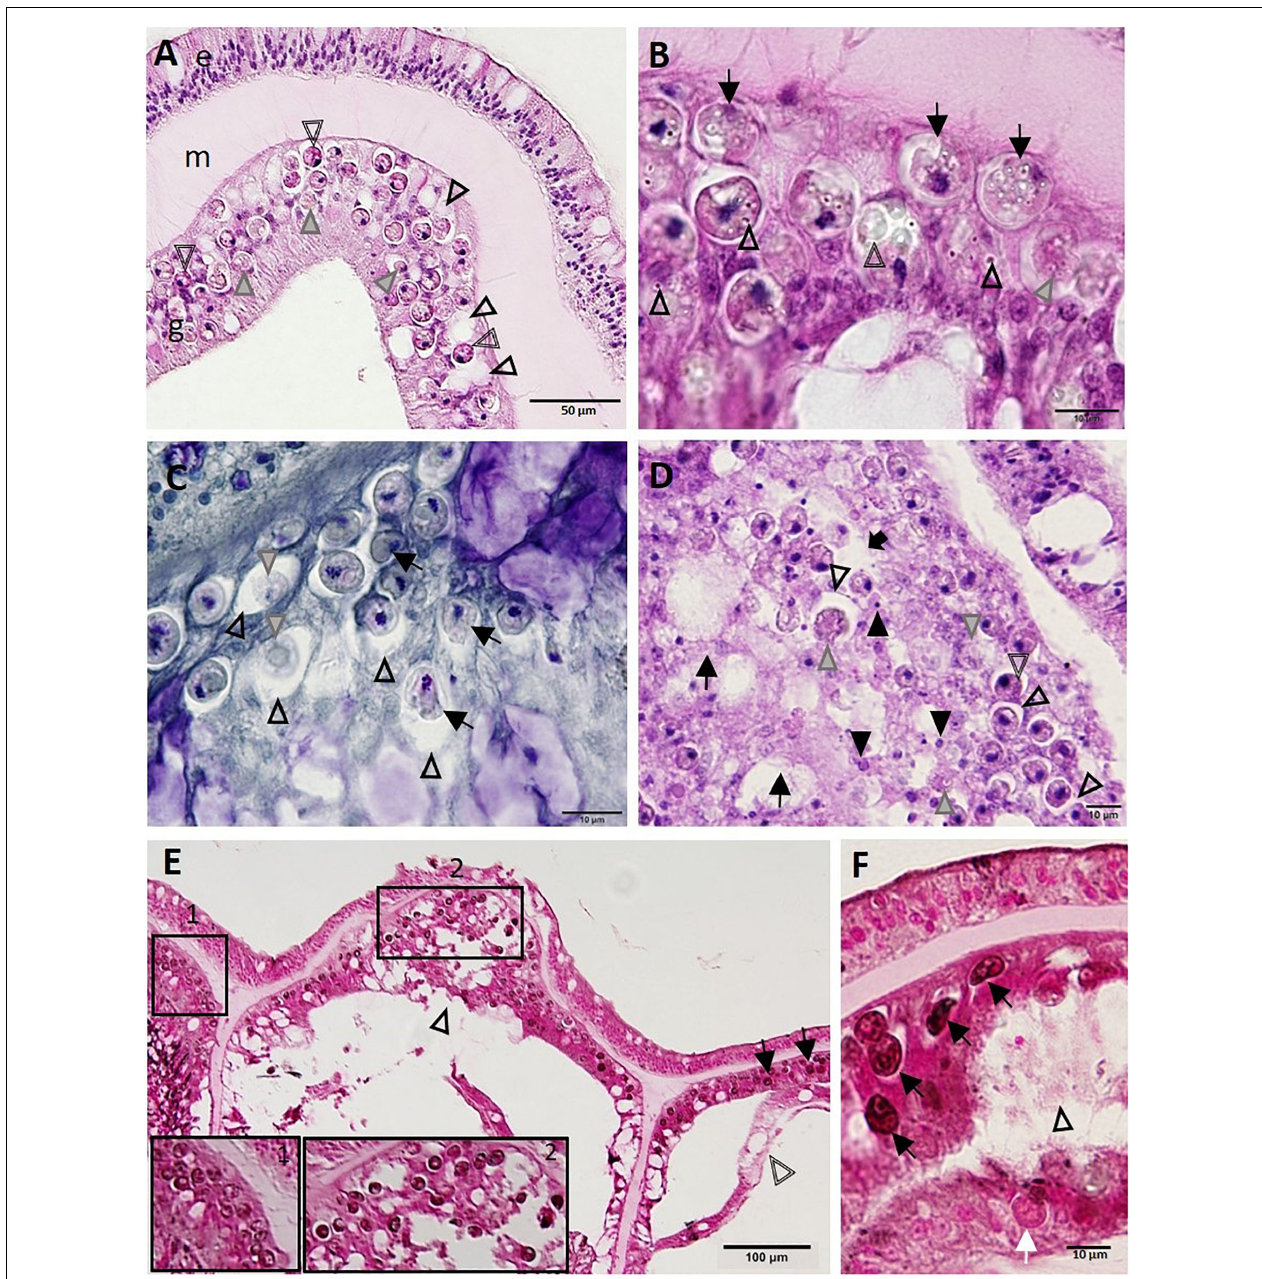
FIGURE 7 | Progressive zooxanthellae pathology in the surface body wall. (A) Intact mesoglea and epidermis with initial zooxanthellae pathology in the gastrodermis in Montastraea cavernosa . Note necrotic zooxanthellae with dilated symbiosomes (gray arrowheads) and cytoplasmic hypereosinophilia (double-line arrowheads), and coalescing vacuolation of the gastrodermis (arrowheads). (B) Gastrodermis of M. cavernosa showing deformed zooxanthellae (arrows) with intracytoplasmic refractile vacuoles (arrowheads), hypopigmentation (gray arrowhead), or fragmentation (double-line arrowhead). (C) Gastrodermis of Diploria labyrinthiformis manifesting zooxanthellae disruption. Note distended symbiosomes (arrowheads) with some zooxanthellae showing deformation (arrows) or coagulation necrosis (gray arrowheads). (D) Gastrodermis of Colpophyllia natans manifesting multifocal necrosis. Note massive disruption and lytic necrosis (LN) of gastrodermal cells (black arrows) with karyorrhectic and pyknotic nuclei (closed arrowheads), deformed and necrotic zooxanthellae (gray arrowheads), some of which manifest cytoplasmic hypereosinophilia (double-line arrowhead) or dilation of symbiosomes (open arrowheads) that eventually coalesce (black arrow). (E) Apparently healthy zooxanthellae (pink-red to light brown) with evident pyrenoids and lack of visible symbiosomes (inset 1) in intact SBW gastrodermis of M. cavernosa . Compare to abnormal dark zooxanthellae with no pyrenoids and dilated symbiosomes (inset 2 and arrows) in LN lesion in surface body wall (SBW) gastrodermis showing marked disruption and vacuolation (arrowhead) and adjacent to basal body wall (BBW) LN lesion (double-line arrowhead). (F) Gastrodermal LN lesion (arrowhead) in M. cavernosa with associated deformed zooxanthellae (black arrows) staining FM-positive (black) compared to a normal (pink-red) zooxanthella (white arrow). (A,B,D) Hematoxylin and eosin (H and E); (C) Macchiavello; (E,F) Fontana-Masson (FM). e, epidermis; g, gastrodermis; m, mesoglea.